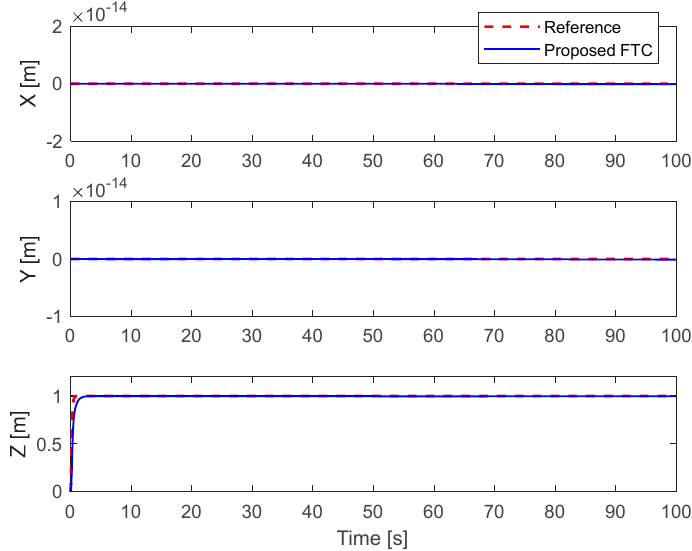
Figure 8. Altitude and position performance with simultaneous fault.